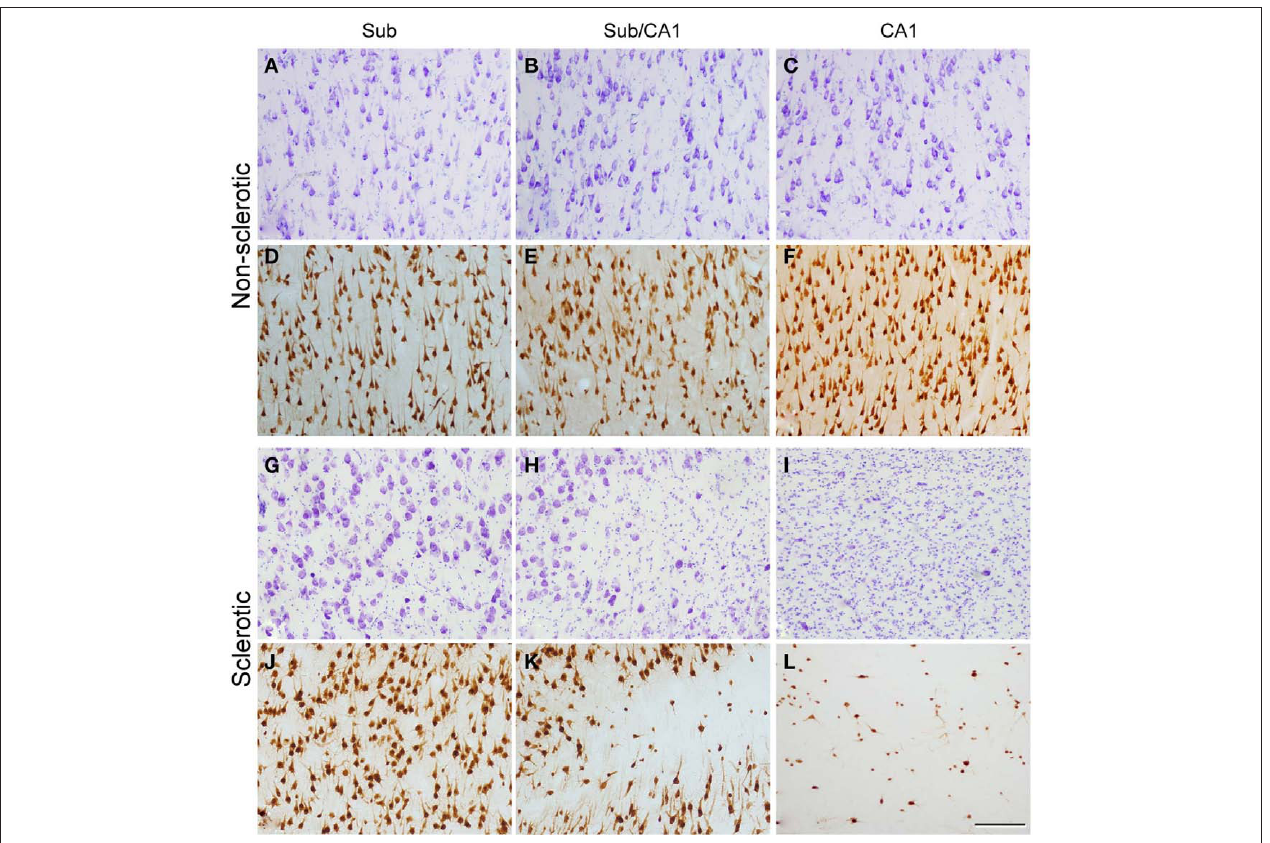
FigurE 2 | Higher magnification of the regions indicated in Figure 1 and from an adjacent NeuN-immunostained section of the same regions from the non-sclerotic (A–F) and sclerotic (g–L) hippocampal formation. The non-sclerotic regions have a typical neuronal distribution, and the sclerotic